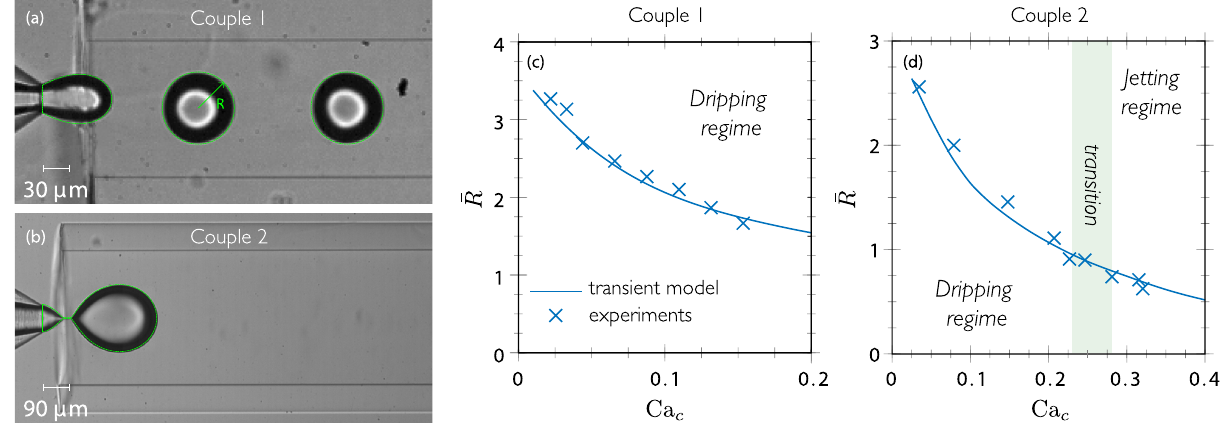
Figure 7. Comparison between transient simulations (green lines) and experimental pictures for the formation of water drops in mineral oil with properties reported in Table 1: ( a ) meniscus for Q c = 150 µ L / min ( Ca c = 0.066 ) and Q d = 25 µ L / min ( Ca d = 0.01 ); ( b ) meniscus at pinch-off for Q c = 700 µ L / min ( Ca c = 0.034 ) and Q d = 20 µ L / min ( Ca d = 0.001 ); ( c , d ) comparisons of droplet size for various values of Ca c in the dripping regime for ( c ) and showing for ( d ) the experimental dripping-jetting transition (shaded area), as identified in Fig. 4.